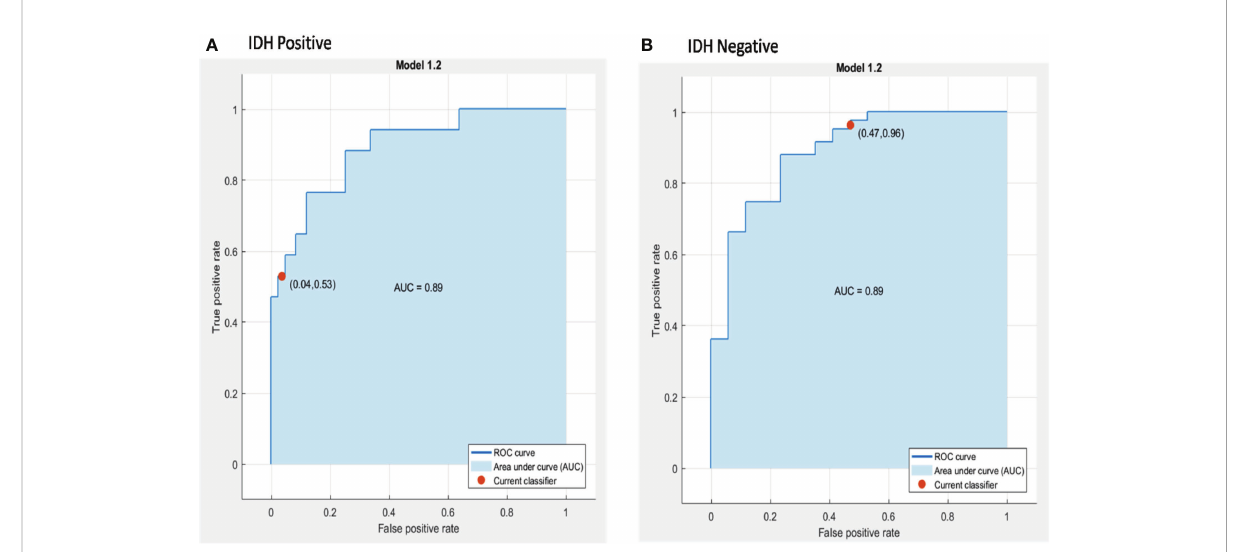
FIGURE 4 ROC curves of the best model for prediction of the two molecular subgroups using combined multi-slice T1 + C and T2w GLCM features using Quadratic SVM, (A) IDH positive and (B) IDH negative.